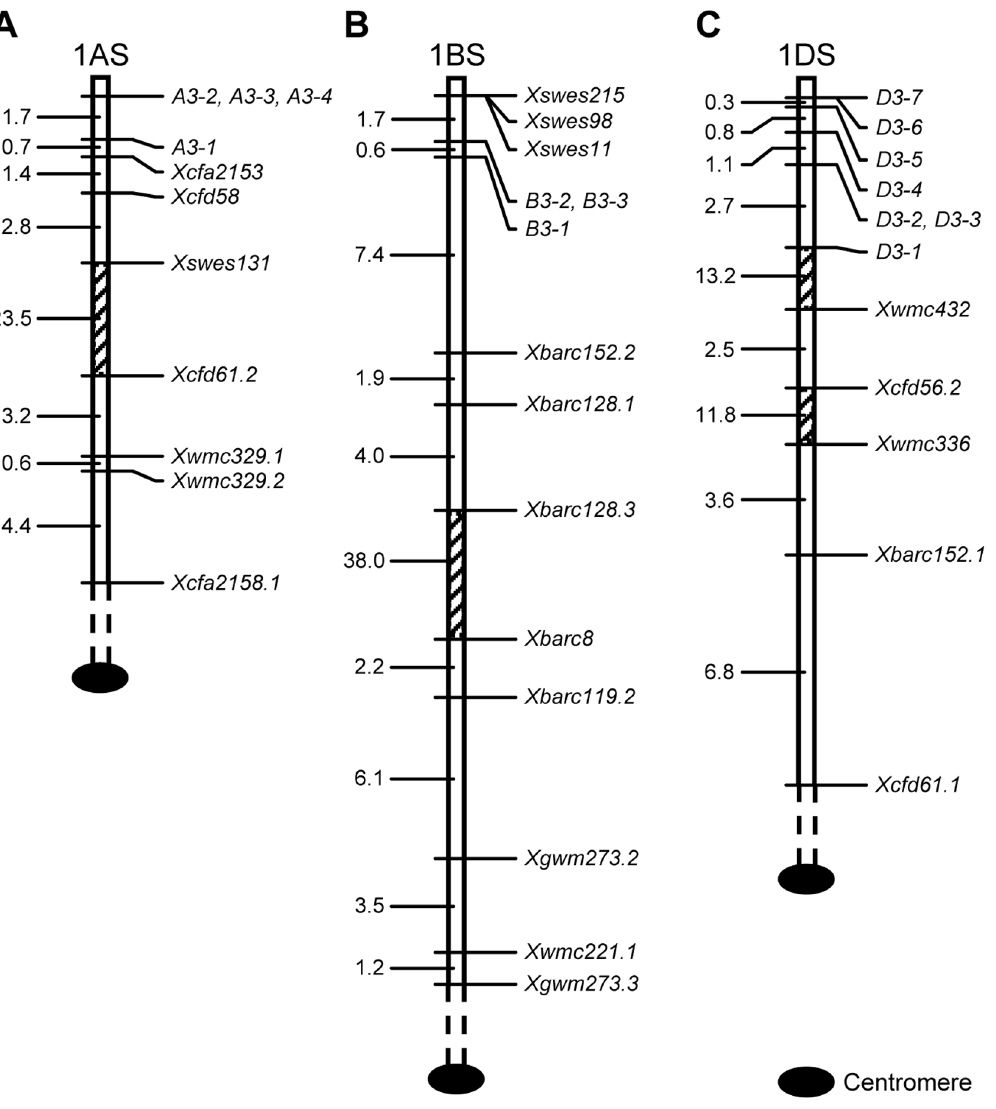
Figure 2. Relative genetic positions of the LMW-GS genes of Xiaoyan 54 in homoeologous group 1 chromosomes. The names of the LMW-GS genes and previously published markers are on the right side, whilst the genetic distance values (cM) between neighboring genes (gene and marker, or markers) are on the left. The hatched areas in the three maps, representing chromosomal regions with large map distances ( . 10 cM), are not drawn in scale. (A) The map positions of four Glu-A3 LMW-GS genes in relation to seven published markers on 1AS. (B) The map positions of three Glu-B3 LMW-GS genes in relation to 11 published markers on 1BS. (C) The map positions of seven Glu-D3 LMW-GS genes in relation to five published markers on 1DS. each of the 11 deduced proteins (Figure S2). A3-1 , predicted to encode a m-type subunit with a putative N-terminal domain sequence MDTSCIPGLERPW, was located at Glu-A3 (Table 1, Figures 2A and S2).